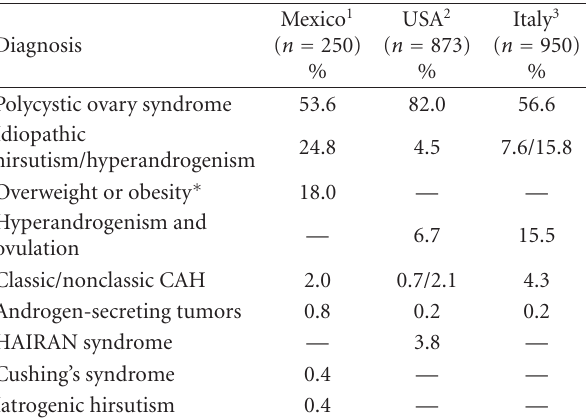
Table 3: Classification of hyperandrogenism in women.